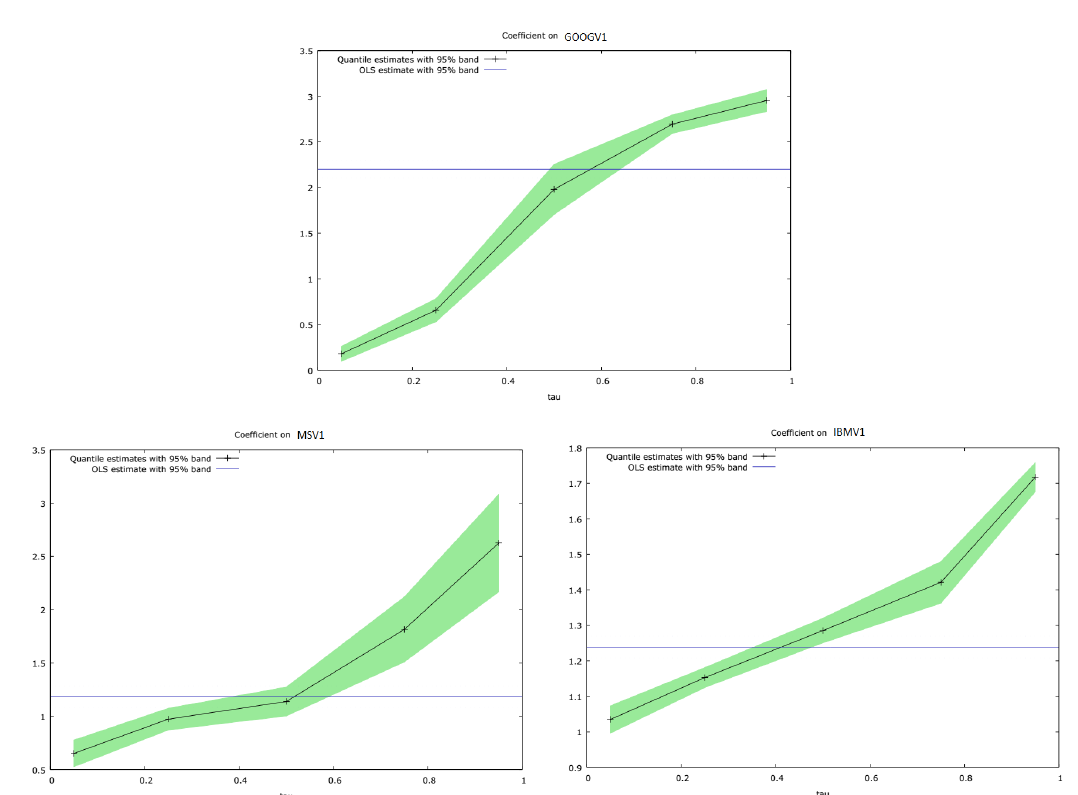
Figure 7. Quantile regression slope coefficient estimates of conditional variance from Full BEKK regressed on DBEKK estimates for GOOGV1, MSV1, and IBMV1. Table 11. Quantile regression results, predicted conditional variance from Full BEKK as the